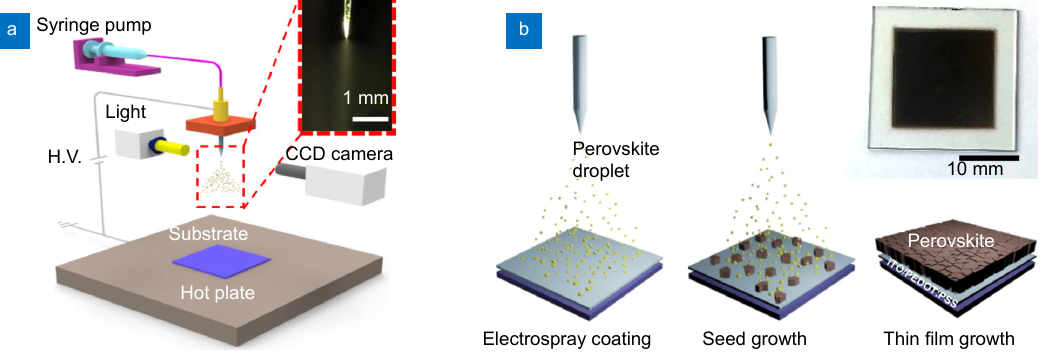
Fig. 9 | Schematics of (a) electrospray deposition setup, and (b) the formation of perovskite films by electrospray deposition 71 . The inset pho- tographs show the cone-jet and perovskite